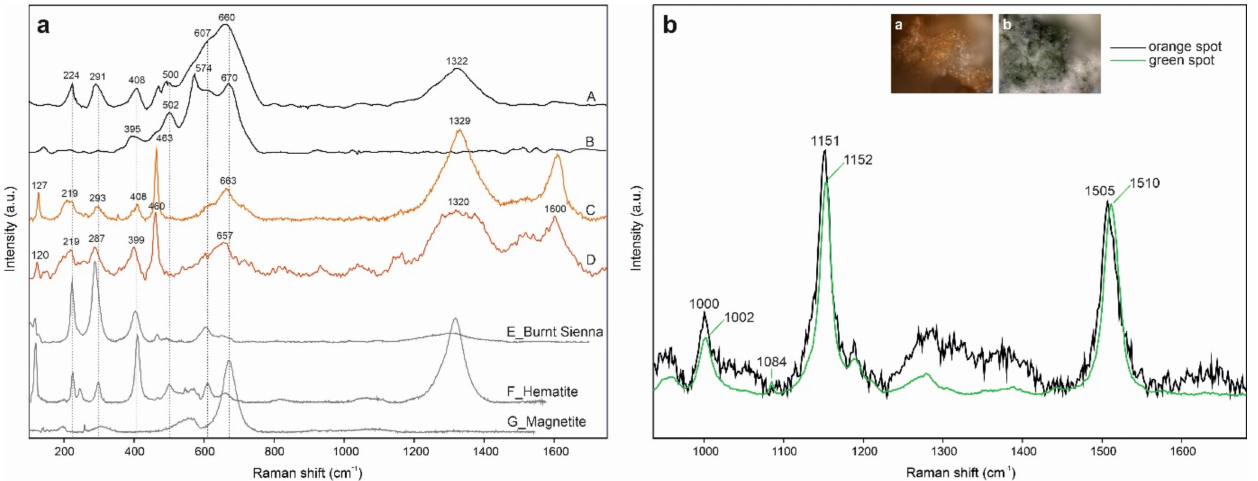
Figure 9. ( a ) Normalized Raman spectra collected from the black varnish on two different spots (A, B), on the orange layer emerging from the black varnish (C) and on the orange crust of sample EZ4 (D) compared with reference spectra of burnt Sienna (E) (Pigments Checker Raman Database [39]), hematite (F) and magnetite (G) (RRUFF [38]) in the spectral range between 150 and 1700 cm − 1 . ( b ) Normalized Raman spectra collected on the orange layer beneath the black crust (a) and on a spot colonized by cyanobacteria (b) in the range from 900 cm − 1 to 1700 cm − 1 , showing the characteristic peaks of